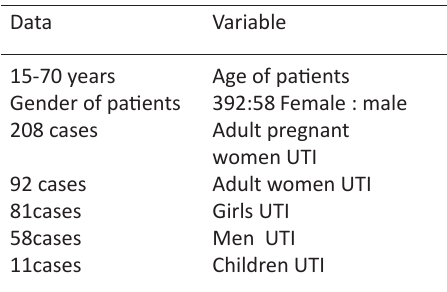
Table 1. Data of Escherichia coli UTI patients